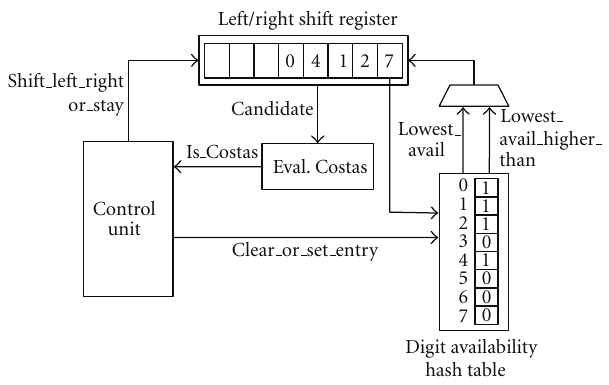
Figure 6: In the illustration, the permutation ( ∗ ,0,4,1,2,7) has just been generated. The hash table keeps record of the digits that are in use in the current permutation (indicated by 1) and outputs two digits, the lowest available and the lowest available higher than the current